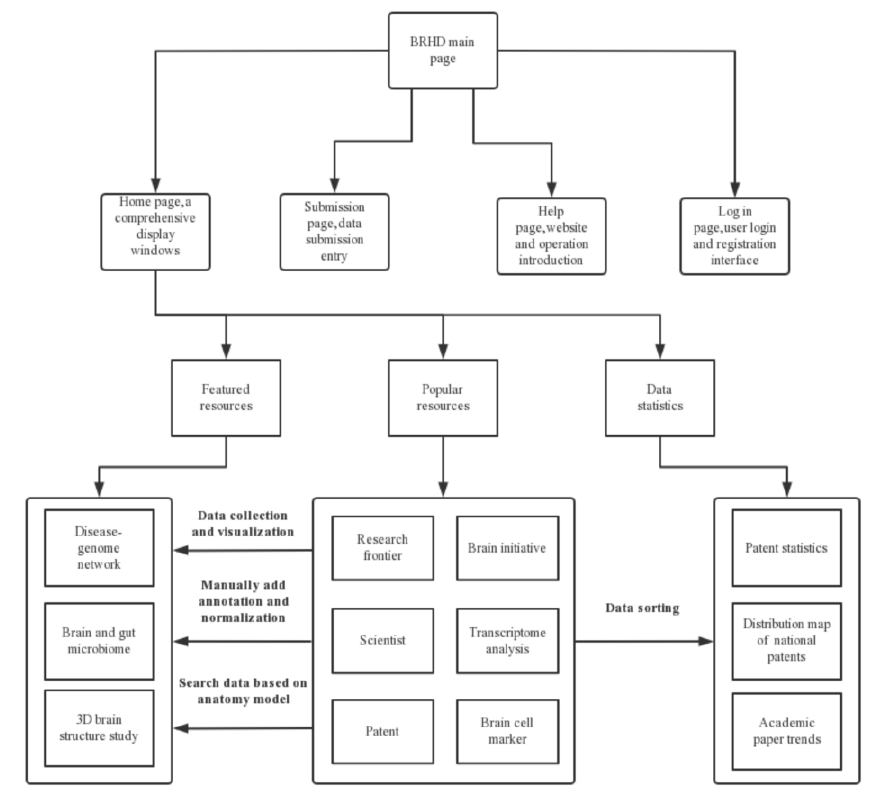
Figure 2. The main components of the BRHD. The BRHD is composed of popular resources and featured resources. Popular resources include the databases of Research frontier, Brain initiative, Scientists database, Transcriptome analysis, Patent, Cell marker. Featured resources includes Disease–genome networks, Brain and gut microbiome relationships, 3D brain structure. There are four tabs in the web server, which are Home page, Submission page, Login page, Help page.